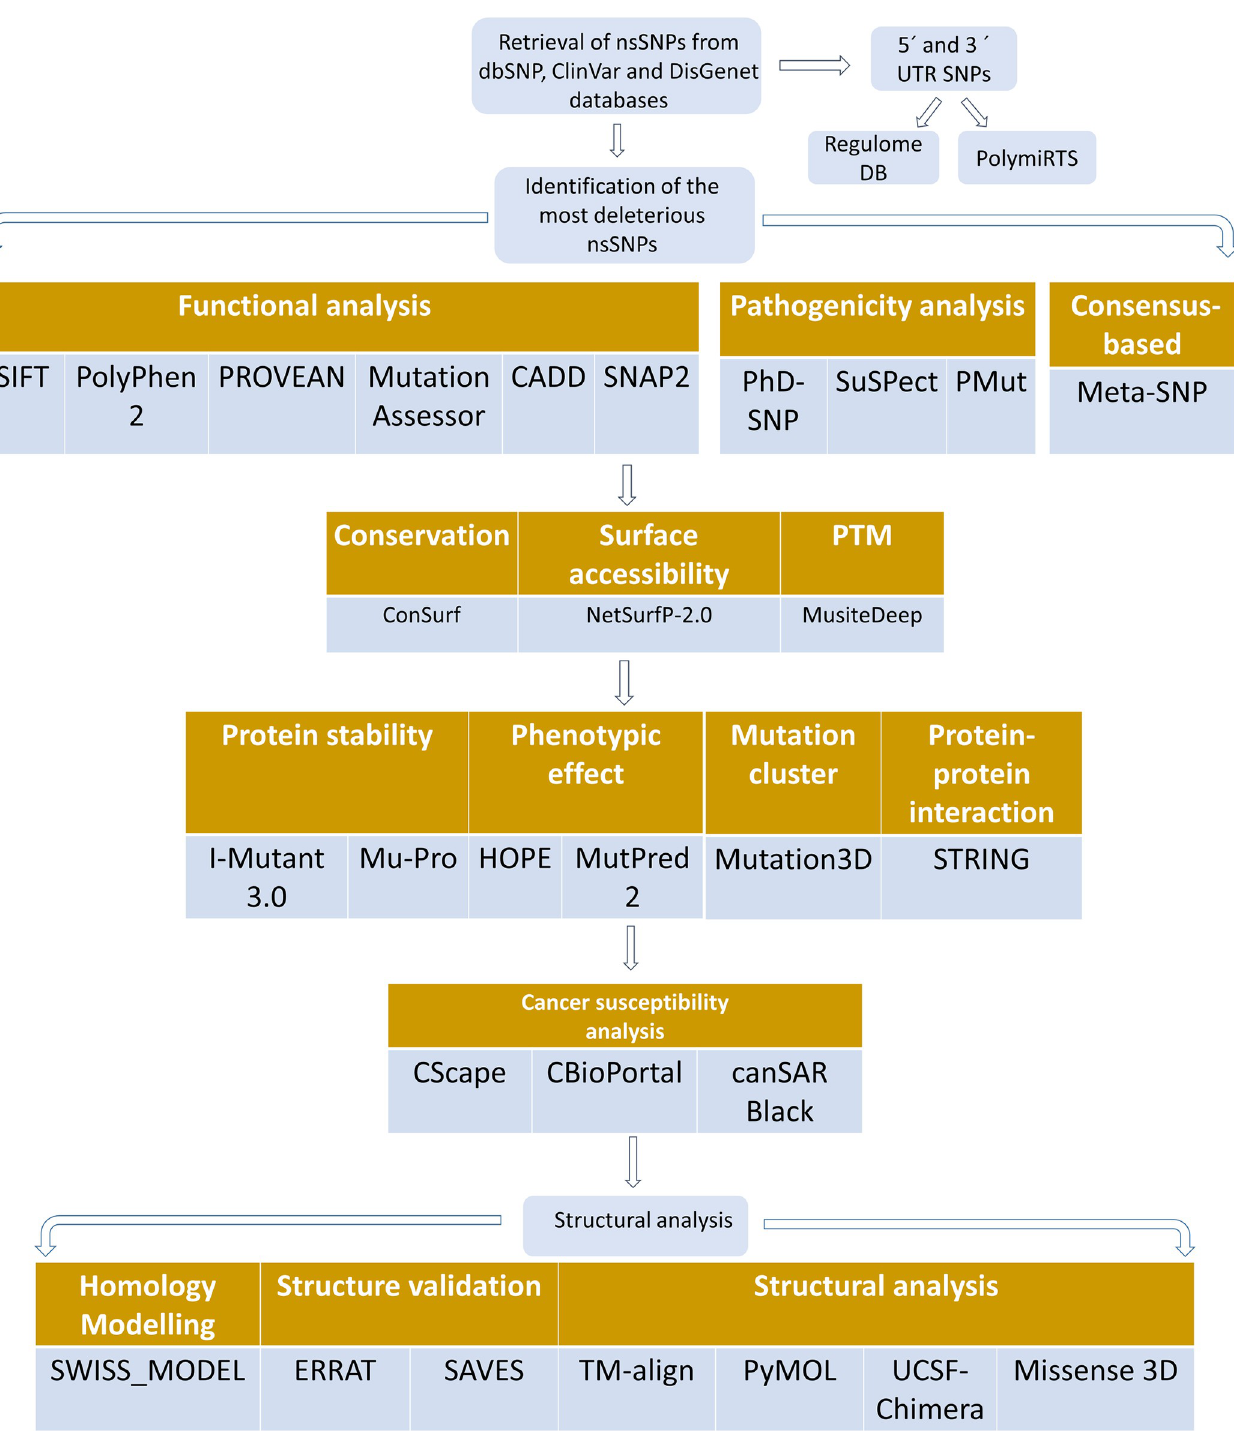
PLOS ONE | https://doi.org/10.1371/journal.pone.0270919 July 5,